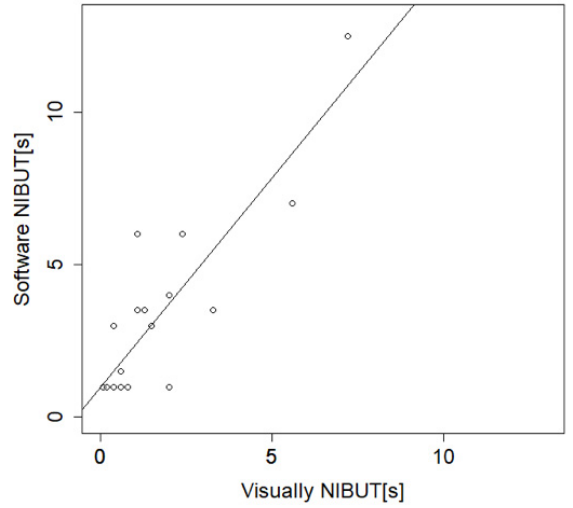
Figure 4. Graph showing correlation between visually detected, and software detected NIBUT in subset of patients where frame button was used by the investigator to identify the frame in which break-up was detected ( n = 20; ID = 21–40). Correlation coefficient is 0.87. One exam (ID33R) was not evaluated because patient had only partial blinks. Subjects consisted of ATD (40%), MGD (50%) and normal (10%). Mean severity score for this group is 2.11 ± 0.81.